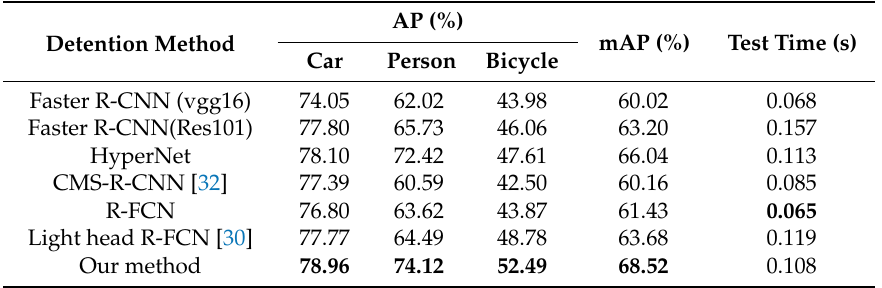
Table 1. The results of different frames on the FILR dataset. Bold numbers indicate the highest indicator values of all frames. IOU threshold is